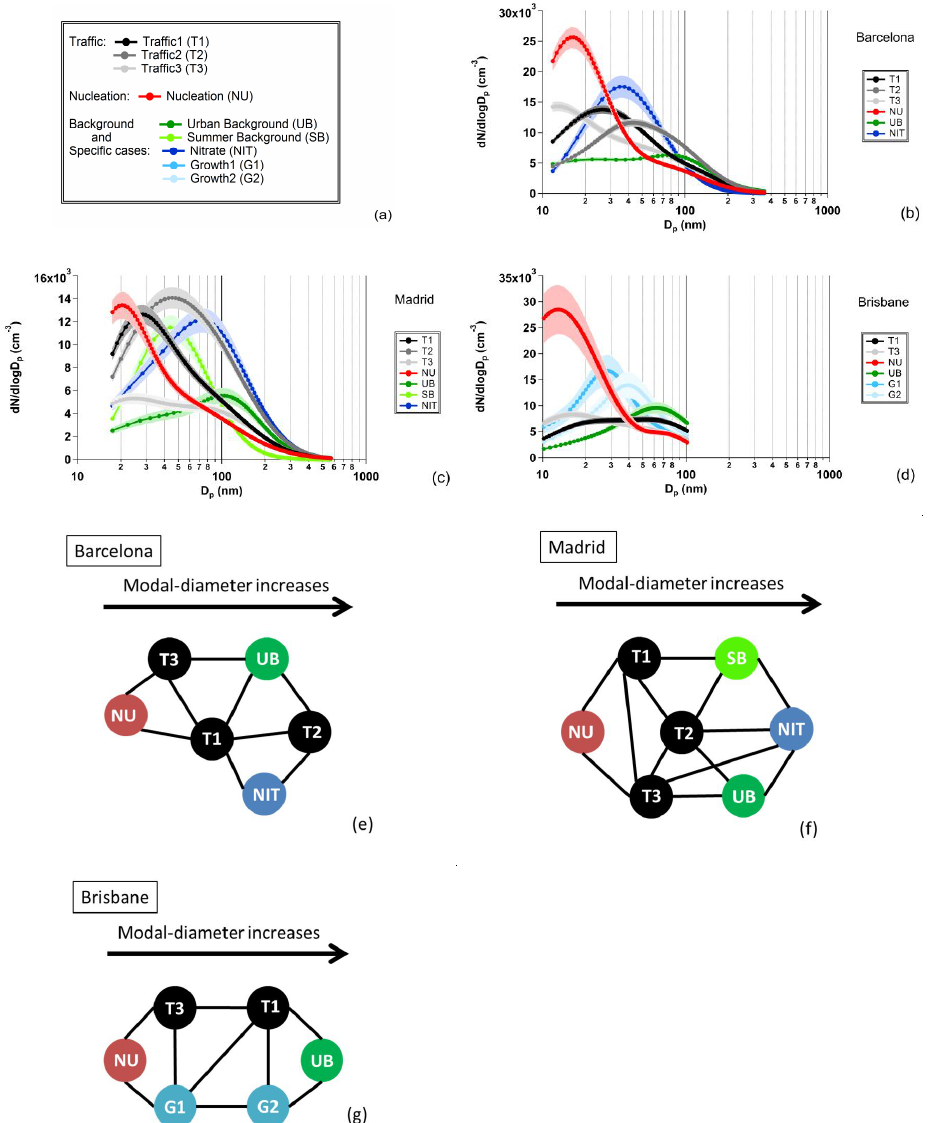
Figure 2. Aerosol size distribution results of the k -means cluster analysis performed on the SMPS data at each selected city: (a) legend, (b) Barcelona, (c) Madrid, (d) Brisbane. Shaded areas around the curves represent the confidence limits µ calculated for 99.9% confidence level. Please note the different scales for d N / dlog D p . The corresponding cluster proximity diagram (CPD) is shown for the three main selected cities: (e) Barcelona, (f) Madrid and (g)